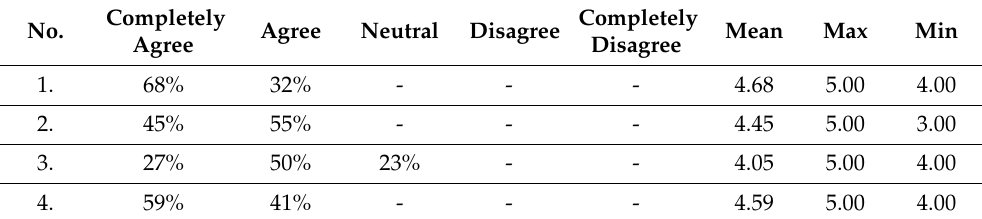
Table 7. The results of the Satisfaction parameter.